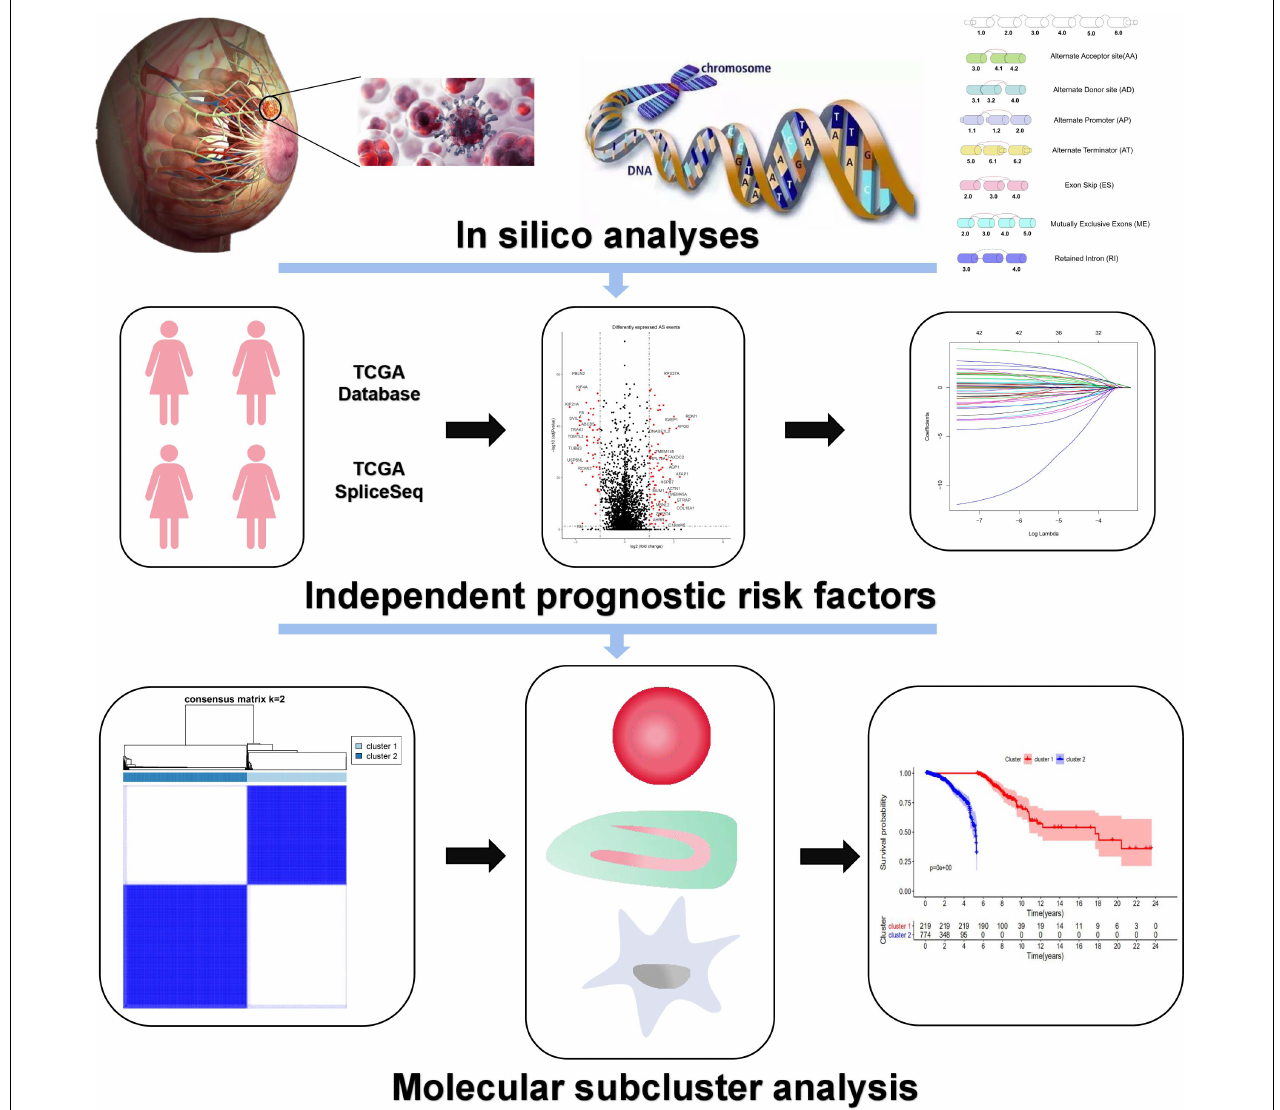
FIGURE 1 | The flowchart for profiling AS of